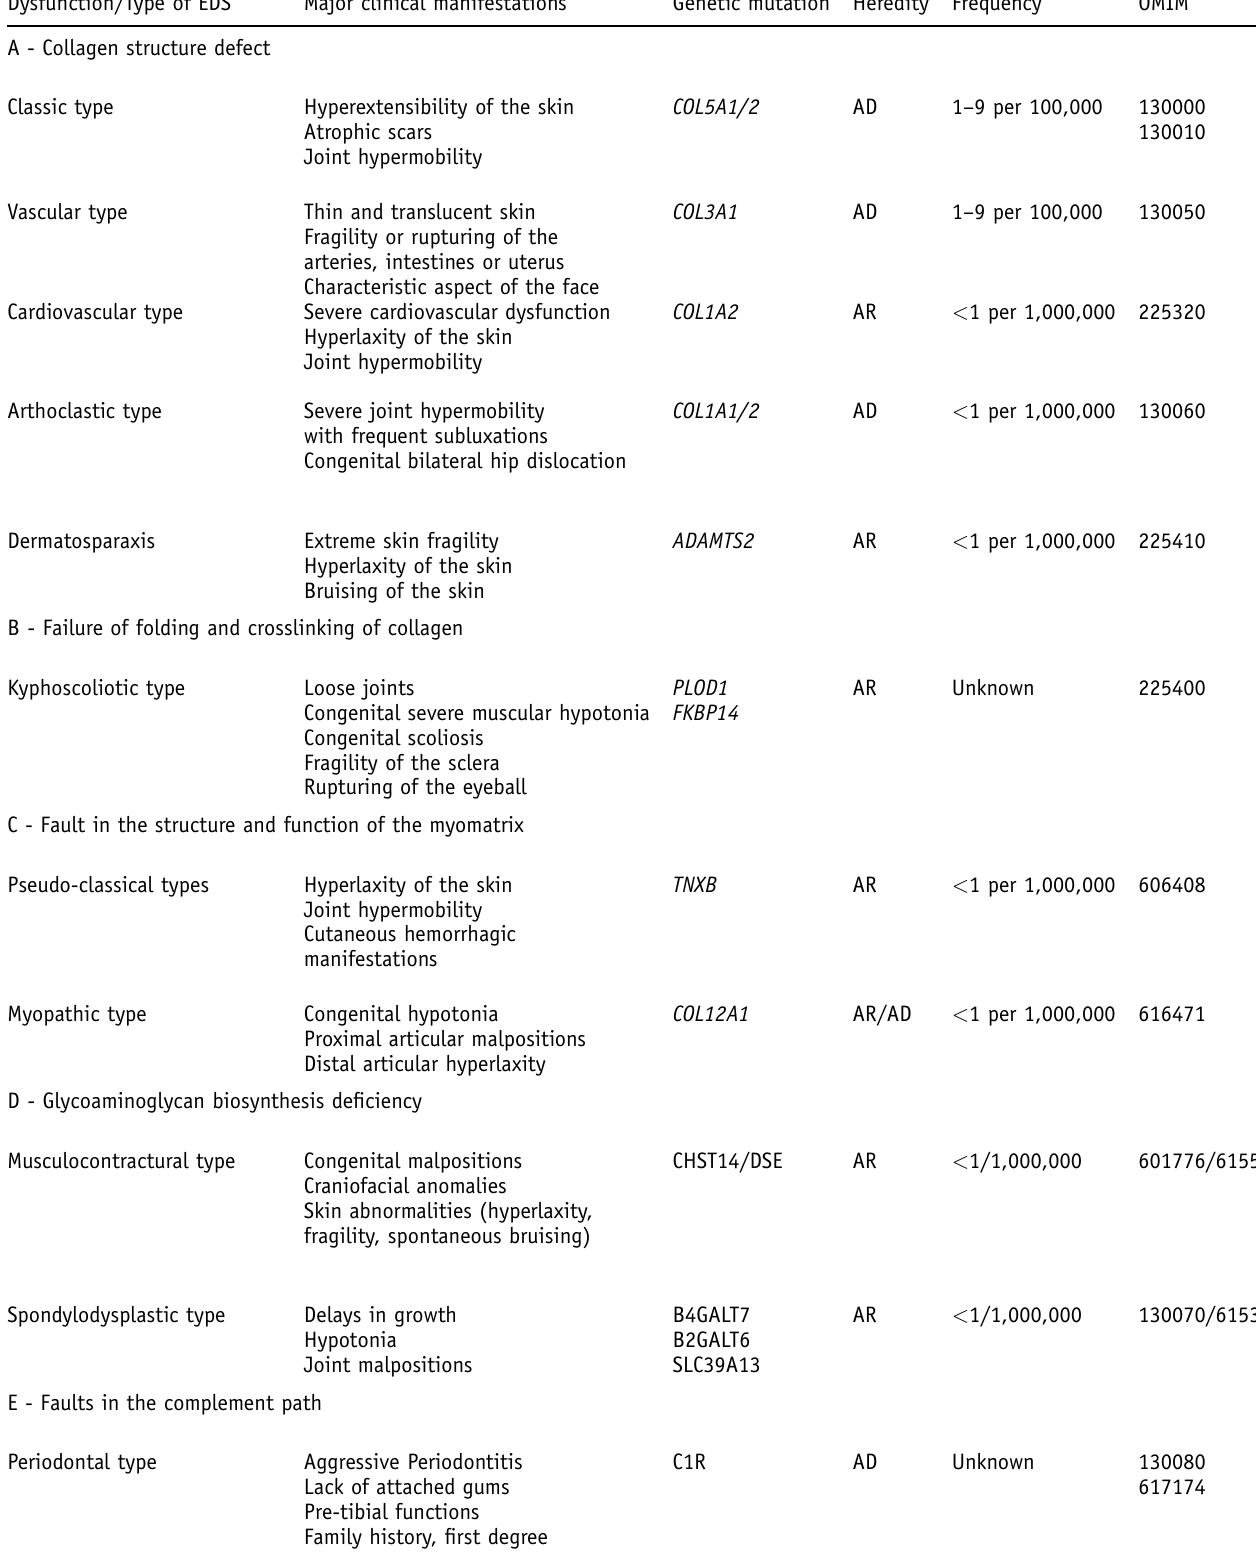
Table II. The 2017 international classi fi cation of EDS (Malfait et al. , 2017 [2]). AD: autosomal dominant; AR: autosomal